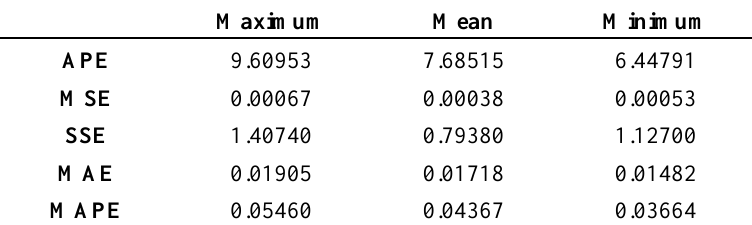
Table 6. Numerical results for